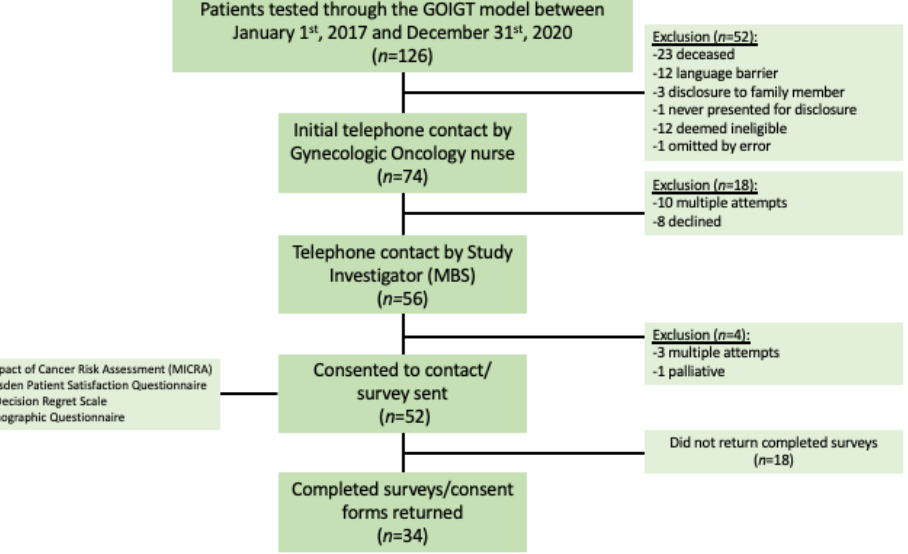
Figure 2. Study design and ascertainment of participants .